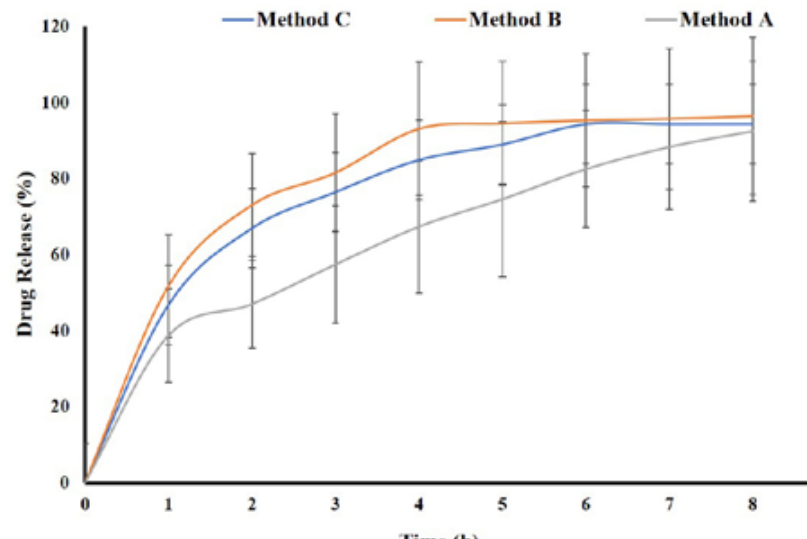
FIGURE 3 - In-vitro release of artemether from erythrocytes followed by three different loading techniques. The results are presented as Mean ±SD of three experiments.